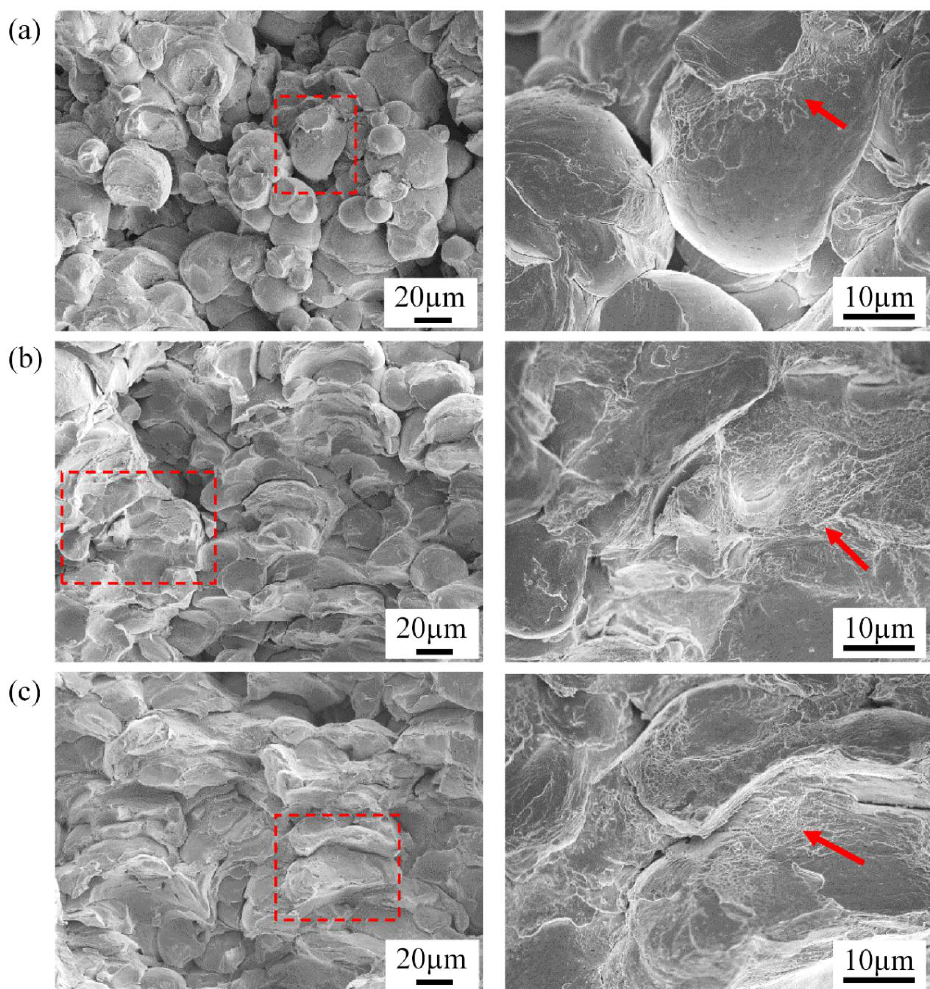
Figure 11. SEM micrographs with different magnifications showing fractured cross-sections Figure 11.